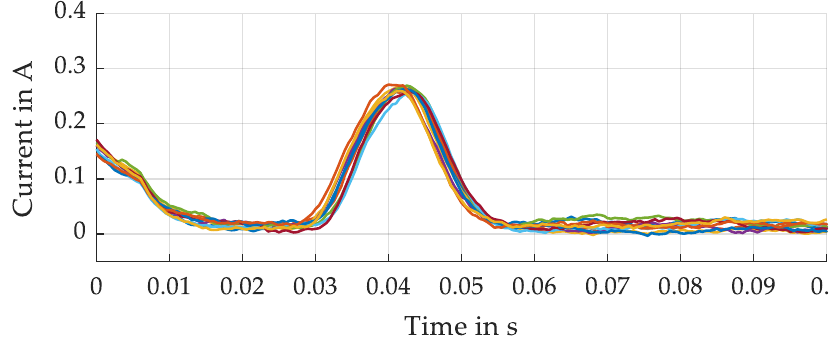
Figure 13. Measured current signals for all measurements.